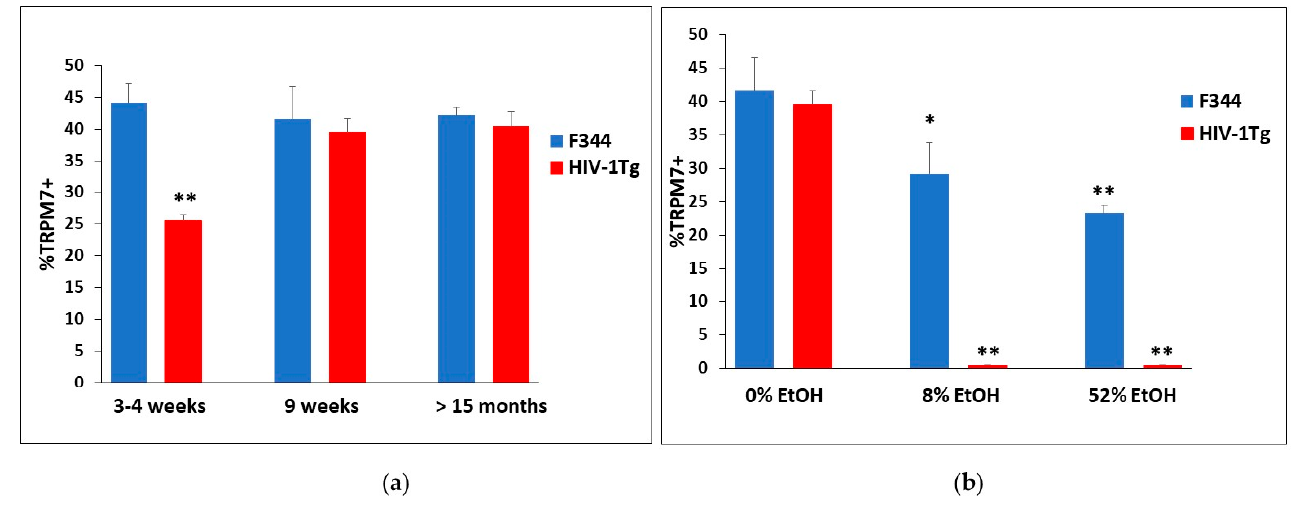
Figure 3. Flow cytometry analysis of TRPM7 expression from HIV-1Tg rBMVECs compared to F344 age-matched control rat BMVECs: ( a ) Differential expression of TRPM7 protein between HIV-1Tg rats and F344 control animals at different ages (3–4 weeks, 9 weeks and >15 months); ( b ) Nine wk old F344 and HIV-1Tg rats were binge treated with either 0%, 8%, or 52% EtOH for 4 wks, and harvested rat BMVECs were stained for intracellular TRPM7 protein. Each sample for flow cyotmetric analysis consisted of 3 rat brains and was repeated in 3 independent experiments, run in triplicate. * p < 0.05, ** p < 0.01.